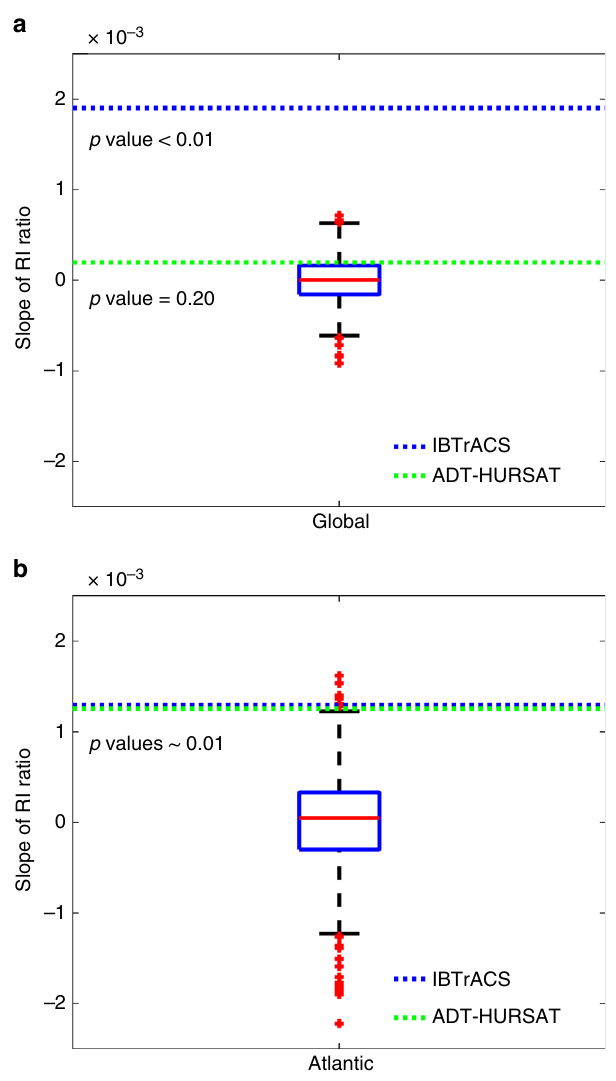
Fig. 5 Observed trends in RI ratio vs. 1860CTL natural variability. a , b Box and whisker plot represents the distribution of slopes of RI ratio in the QDM-corrected 1860 HiFLOR control simulation. a Global and b Atlantic basin results are plotted. Each slope is calculated by applying least squares regression analysis to annual RI ratio values in overlapping 28-year periods. Thus, the number of slopes for a control simulation is the number of available years subtracted by 28 (i.e., 1860CTL has 1422 slopes). The red line in each box indicates the median of the slopes. The box is bounded by the 25th and 75th percentiles of the data, and the whiskers bracket approximately 99% of the data. Red plus signs indicate outliers whose values are outside of whiskers ’ range. IBTrACS and ADT-HURSAT trends in annual mean RI ratio between 1982 and 2009 are respectively represented by blue and green dotted lines and the corresponding p values are listed below each 28-year RI ratio slopes in the bias-corrected HiFLOR control simulations are compared to the ADT-HURSAT and IBTrACS RI ratio slopes between 1982 and 2009. Supplementary Figure 4 shows how the probability distribution of RI ratio slopes changes when selecting 28-year segments from HiFLOR 1860CTL that are independent and not independent. The plotted bins show the independent sample has a slightly broader distribution but in general, the probabilities of the bins are similar to those in the overlapping bins.